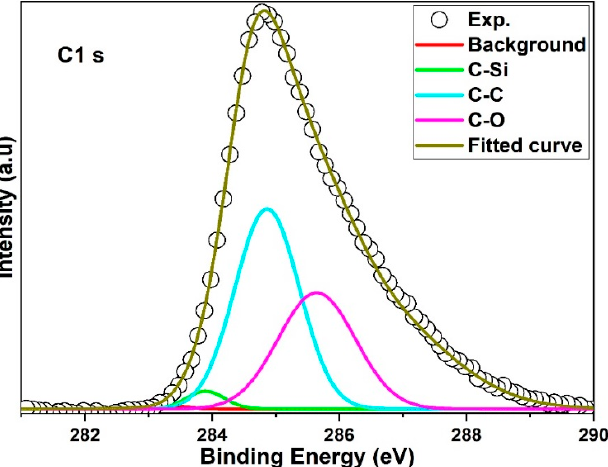
Figure 9. XPS of C 1s spectrum.